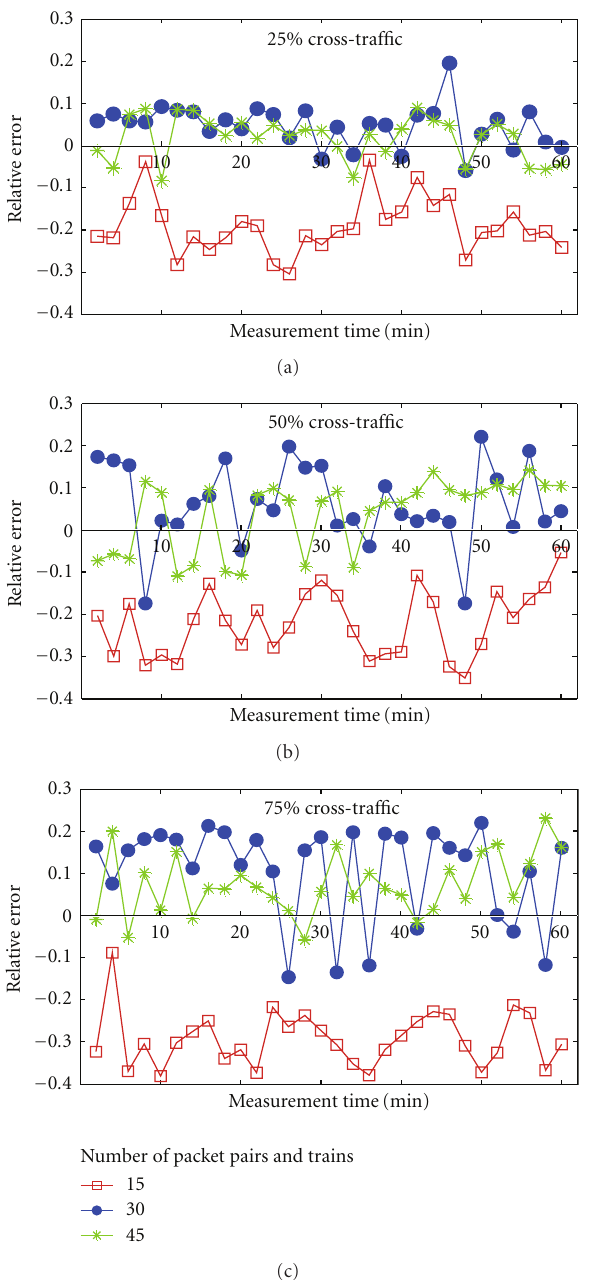
Figure 6: Available bandwidth estimation error for (a) 25%, (b) 50%, and (c) 75% cross-tra ffi c.